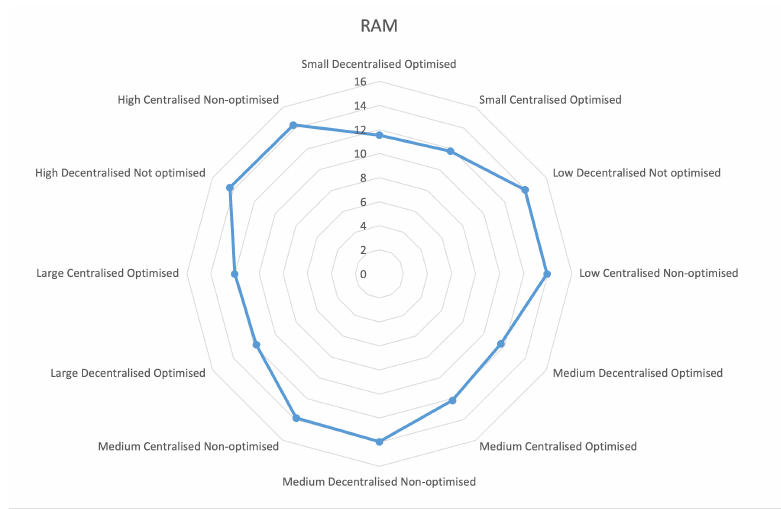
Figure 7. Usage of CPU.